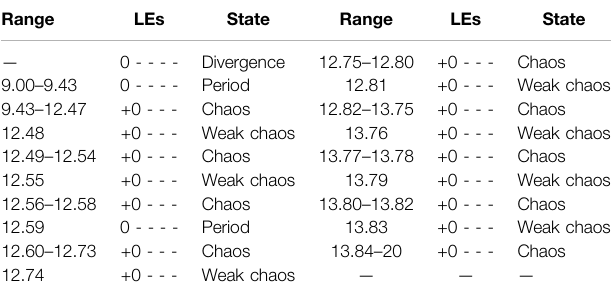
TABLE 3 | System state corresponding to different parameter d when the original conditions is (1, 1, 1, 1, 1). Range